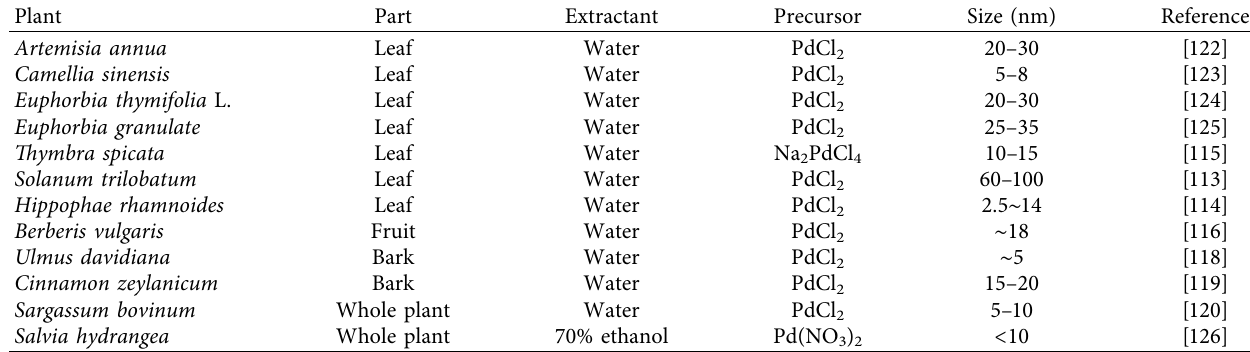
Table 5: Representative examples for the use of plant extracts for PdNP